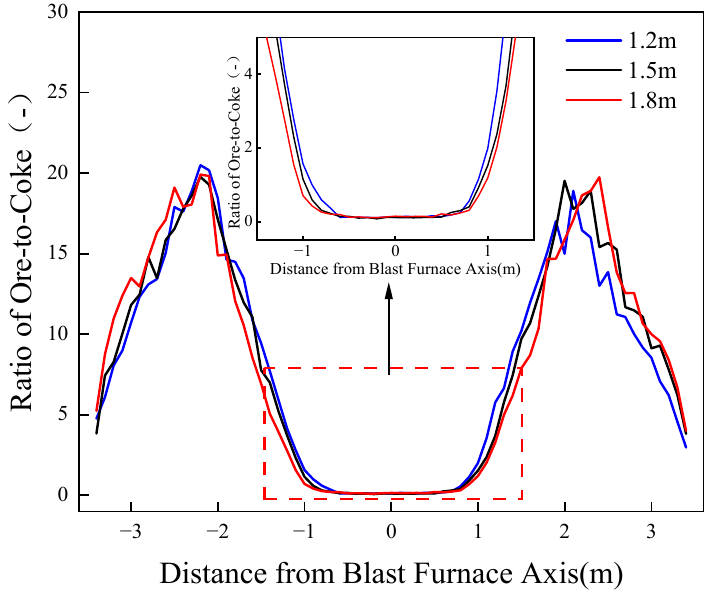
Figure 9. Schematic diagram of the delineated sampling area.